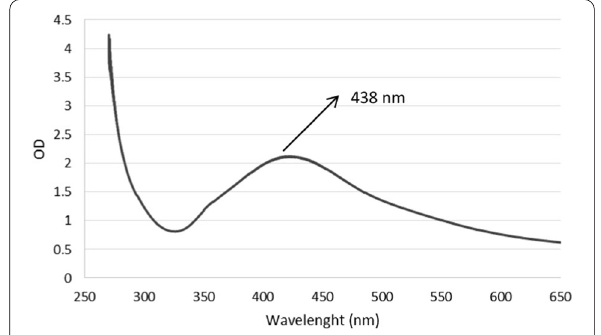
Fig. 1 UV–visible spectrum of biologically synthesized silver